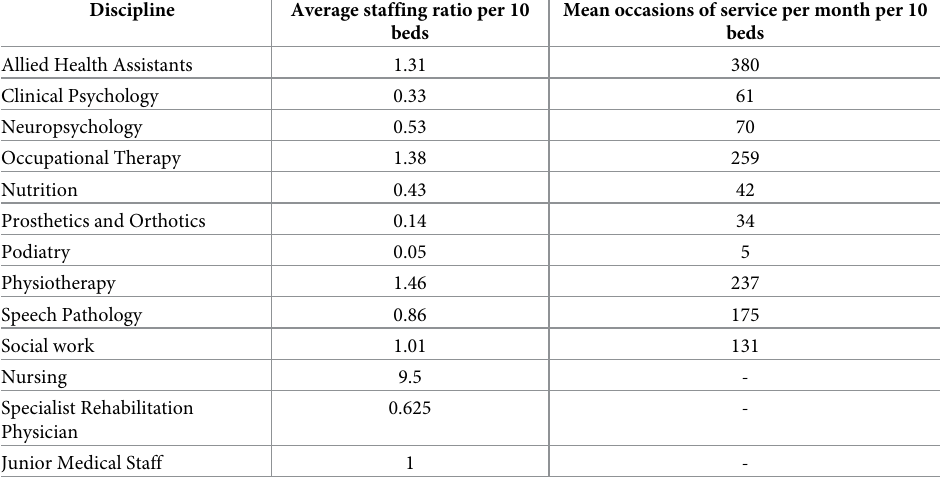
Table 1. Staffing profile during intervention